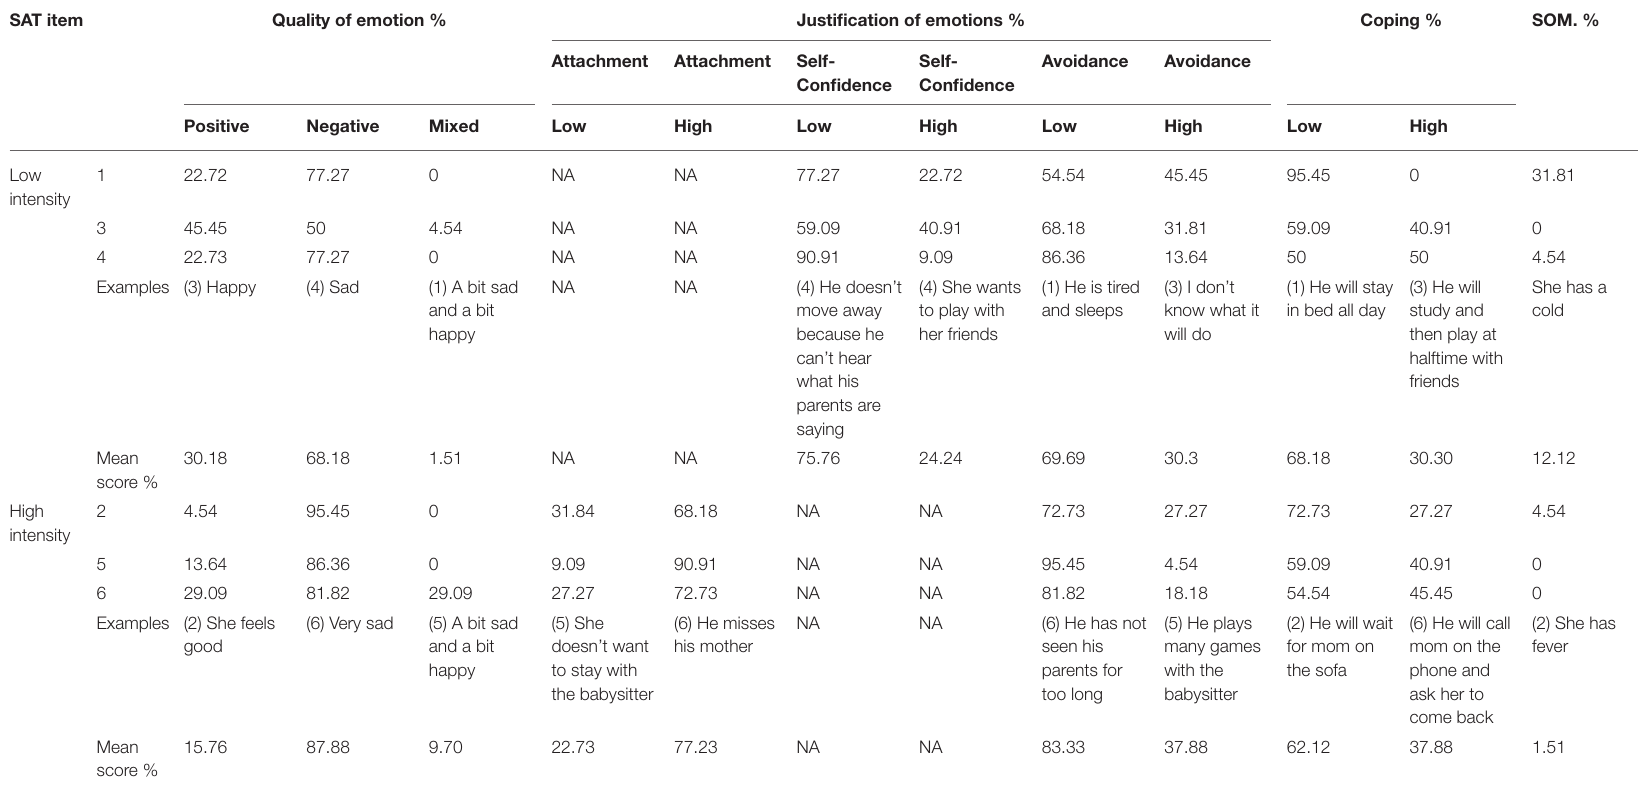
TABLE 2 | Classification of the answers to the “emotion,” “justification,” and “coping” questions of the SAT. SAT item Quality of emotion % Justification of emotions % Coping % SOM. % Attachment